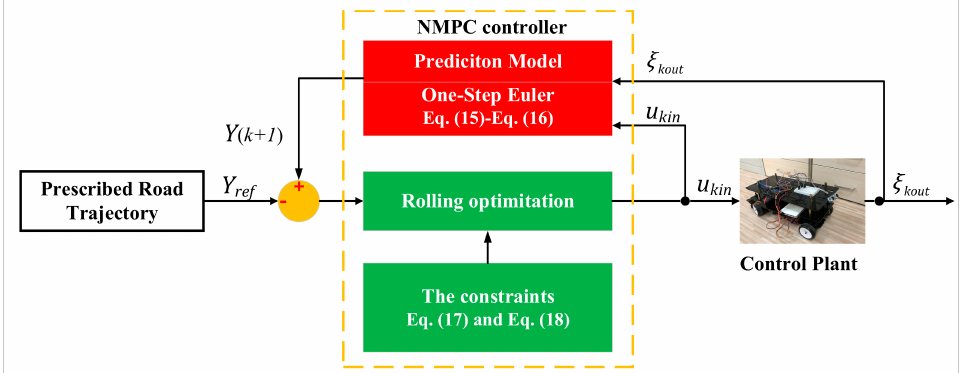
Figure 2. Block diagram of proposed NMPC